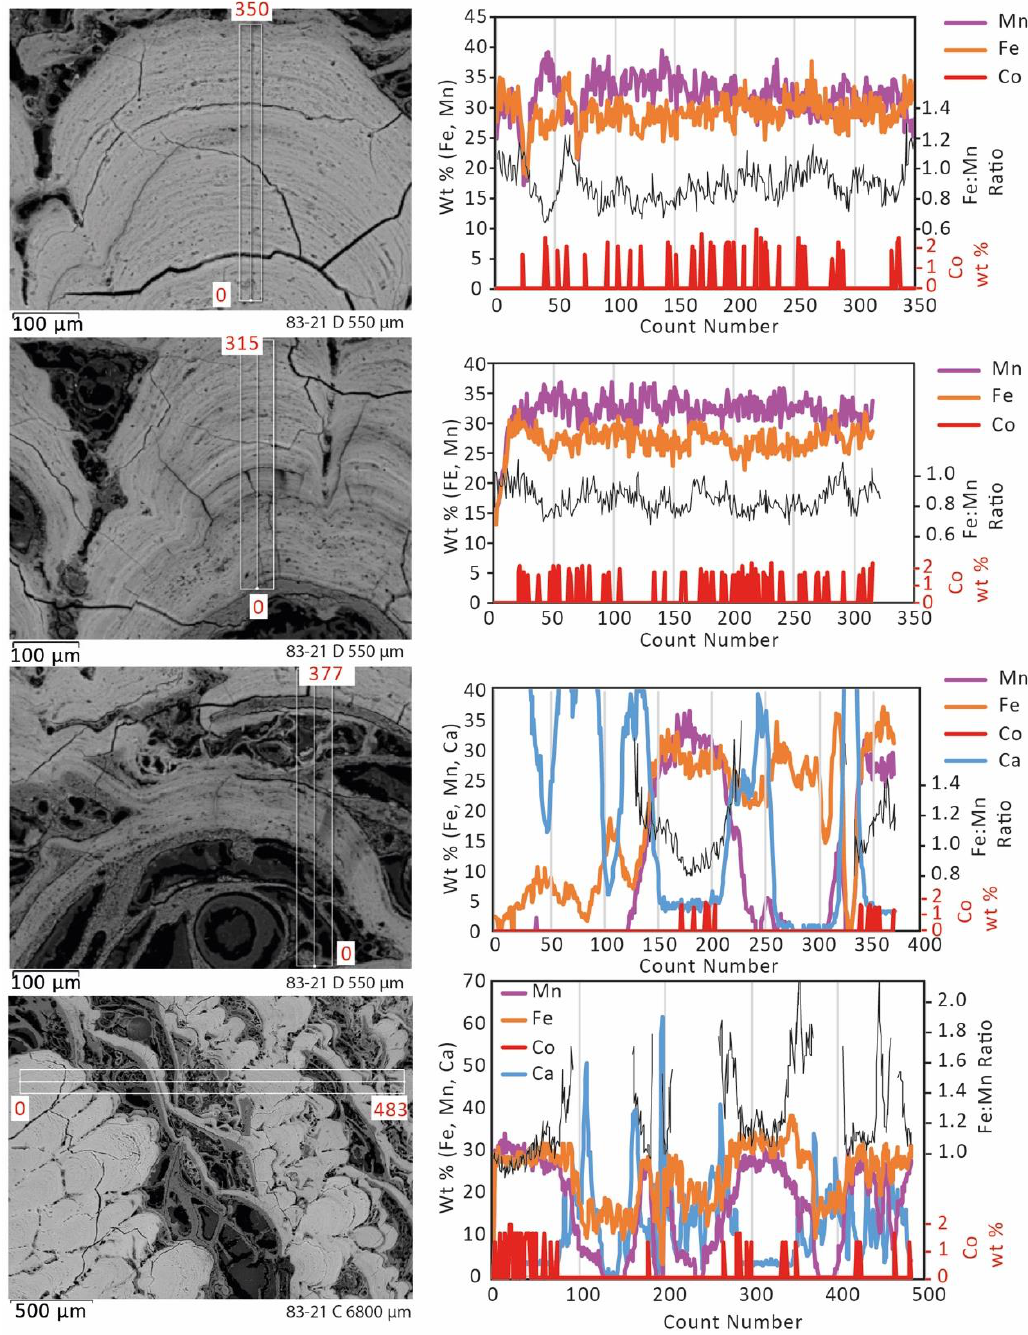
Figure 6. Compositional variations in Mn, Fe, and Co (and Ca) along transects measured with SEM-EDS. The white boxes indicate the area analyzed. The black dashed lines are Fe/Mn ratios and correspond to the scale on the right-hand side of the graphs. Fe and Mn can be seen to vary inversely with each other, while Mn and Co are only found in areas of the FeMn crust. Importantly, the Fe, Mn, and Co concentrations do not vary much between the crusts found in the different textures. In the lowermost scan through the cuspate textures, the Ca spikes correlate inversely with the presence of Mn and Co. All compositional measurements were made on dry samples. To apply these compositions to water-saturated samples, it was necessary to compare the mass of the two sample types. A representative dry sample had 89.3% of the mass of a water-saturated sample. Therefore, for the